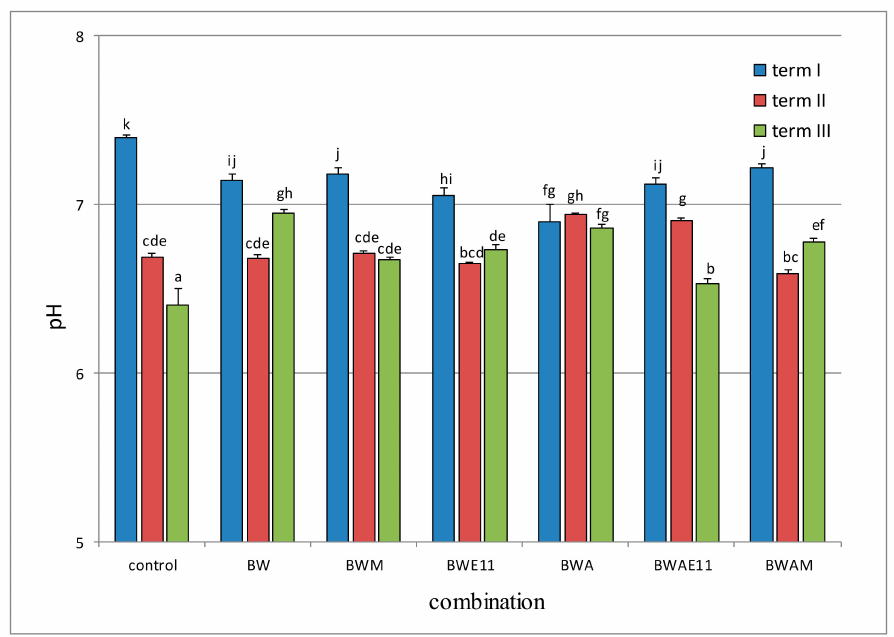
Figure 4. The changes of the pH value of soil. Explanation: Means followed by the same letters do not differ significantly at p ≤ 0.05; control—the control variant without fertilisers, BW—biochar